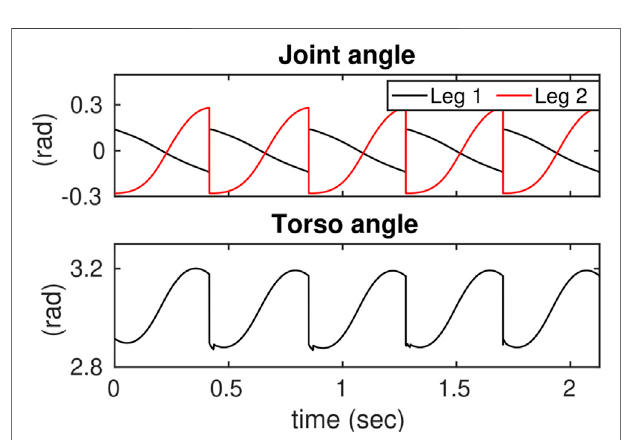
FIGURE 10 | Illustrates the effects of reducing the control thresholds on the control actions and their corresponding phase portraits.